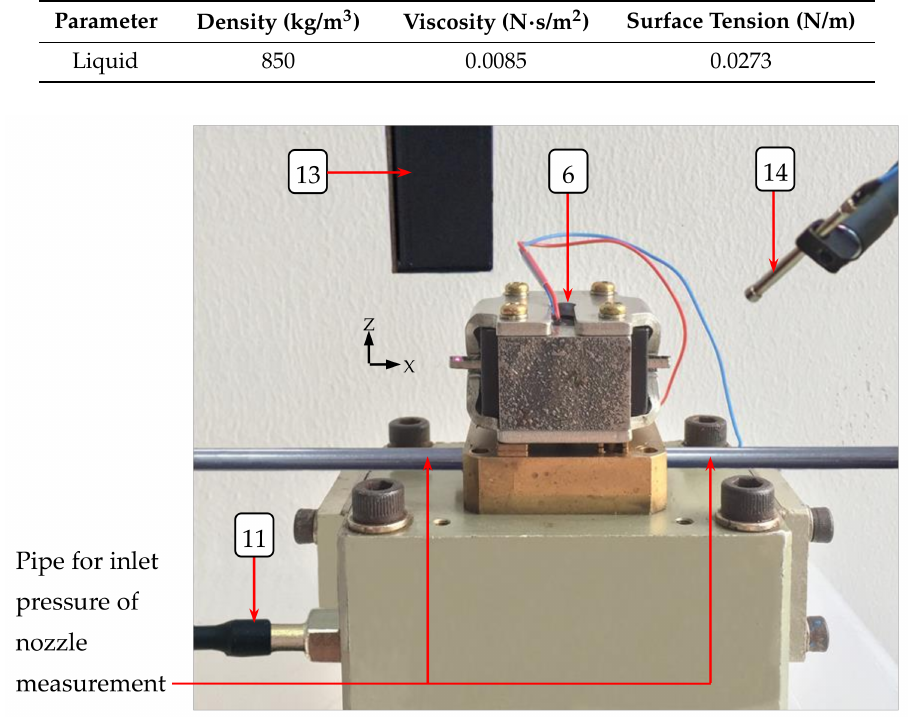
Figure 6. Schematic diagram of the experimental setup: 1, Oil tank; 2, motor; 3, axial piston pump; 4, filter; 5, relief valve; 6, servo, valve; 7, throttle valve; 8, data acquisition board; 9, motor controller 10, computer; 11, piezoelectric pressure sensor; 12, pressure gauge; 13, laser displacement sensor; 14, piezoelectric microphone; 15, rotation speed sensor. Table 3. Properties of the hydraulic oil.